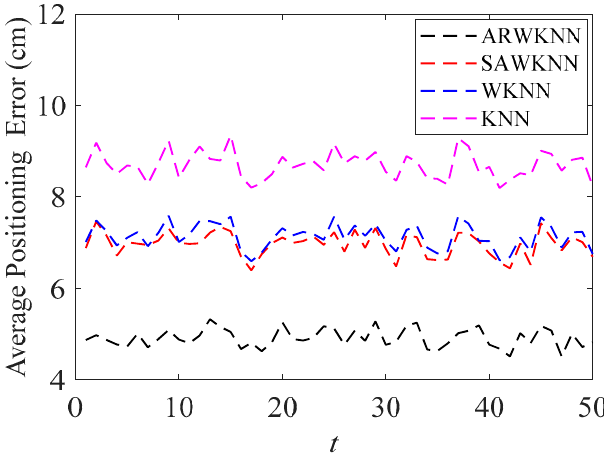
Figure 18. In 2-D, the impact of t on the average positioning error with K max = 4.